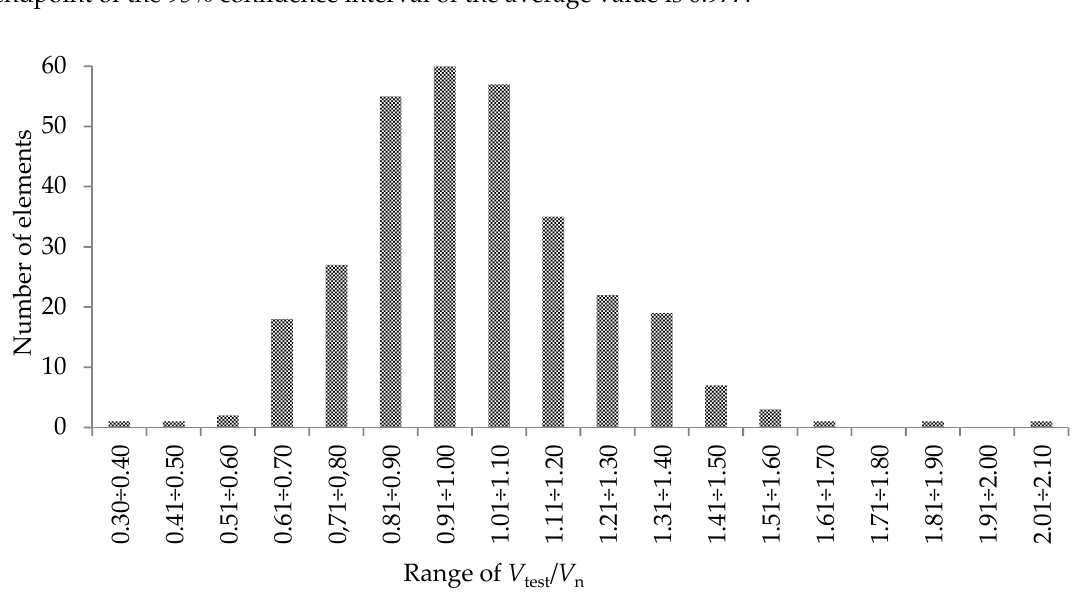
Figure 1. Distribution of values of the ratio of the shear resistance attained experimentally, V test , to the corresponding analytical, V n for particular